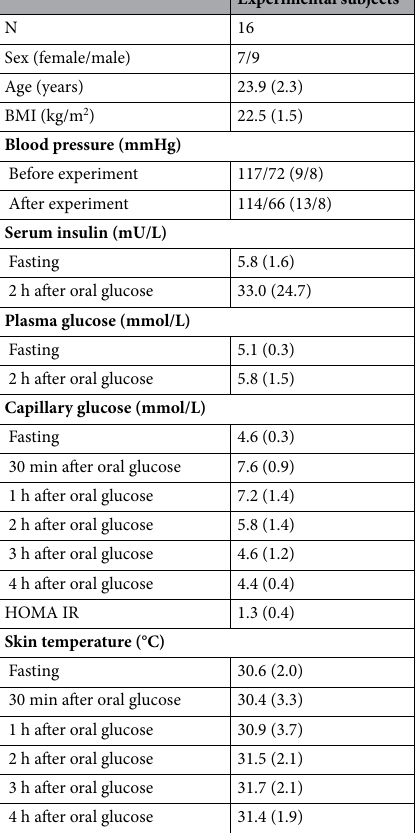
Table 1. Demographics of the subjects enrolled in the study. Data presented in mean